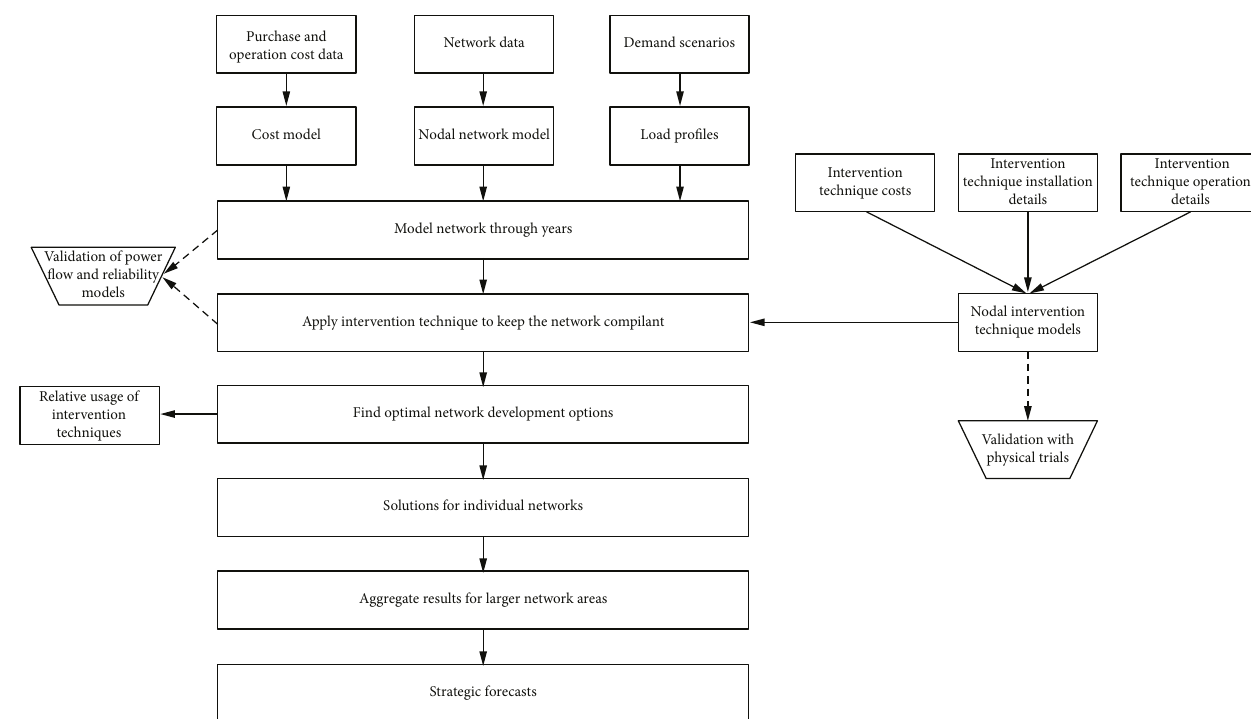
Figure 8: Bottom-up conceptualisation of evolutionary power networks